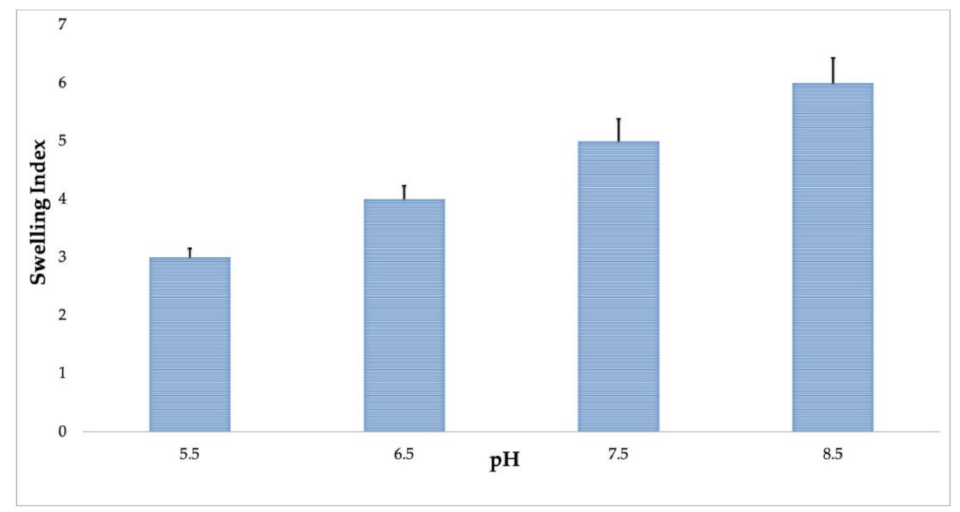
Figure 2. Swelling index of okra mucilage biopolymer at different pH. All experiments were per- formed in triplicate, and data represent mean ± standard